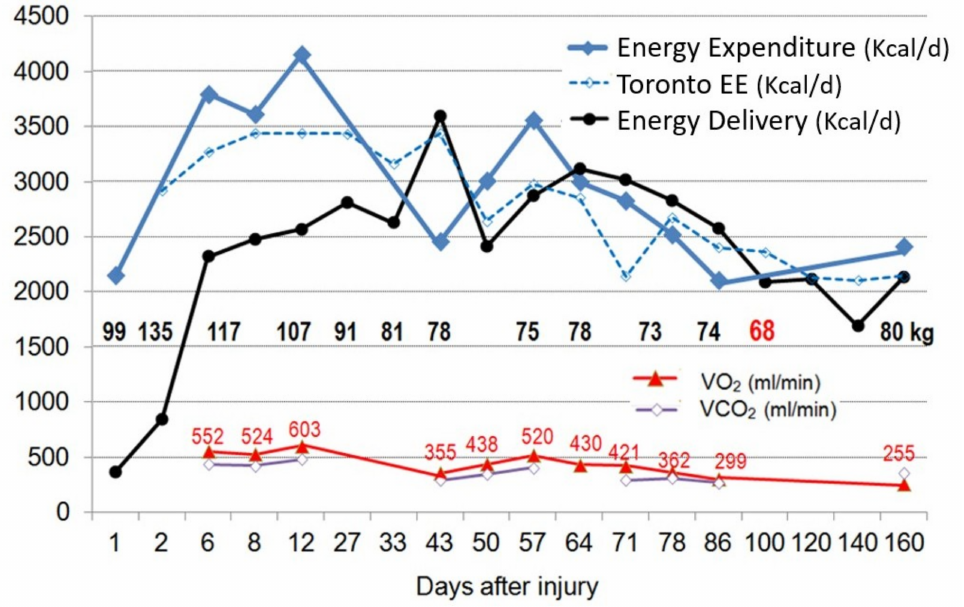
Figure 3. Evolution of measured REE by IC (blue), Toronto predictive equation (dashed blue), delivered energy (black), VO 2 (red (cid:52) ), and VCO 2 (purple ) in a young man weighing 99 kg upon admission with major burns covering 85% body surface over 160 days. The REE variations were important over time particularly during the early phase (weight gain due to fluid resuscitation was 36 kg by day 3), and paralleled the loss of body weight, i.e., of lean body mass ( − 31 kg after 3 months, with slow recovery). The REE value on day 1 corresponds to the Harris & Benedict prediction of basal EE. The figure also shows the reasonable precision of the Toronto equation, and how di ffi cult it is to feed to measured IC value during the first 14 days. Adapted from